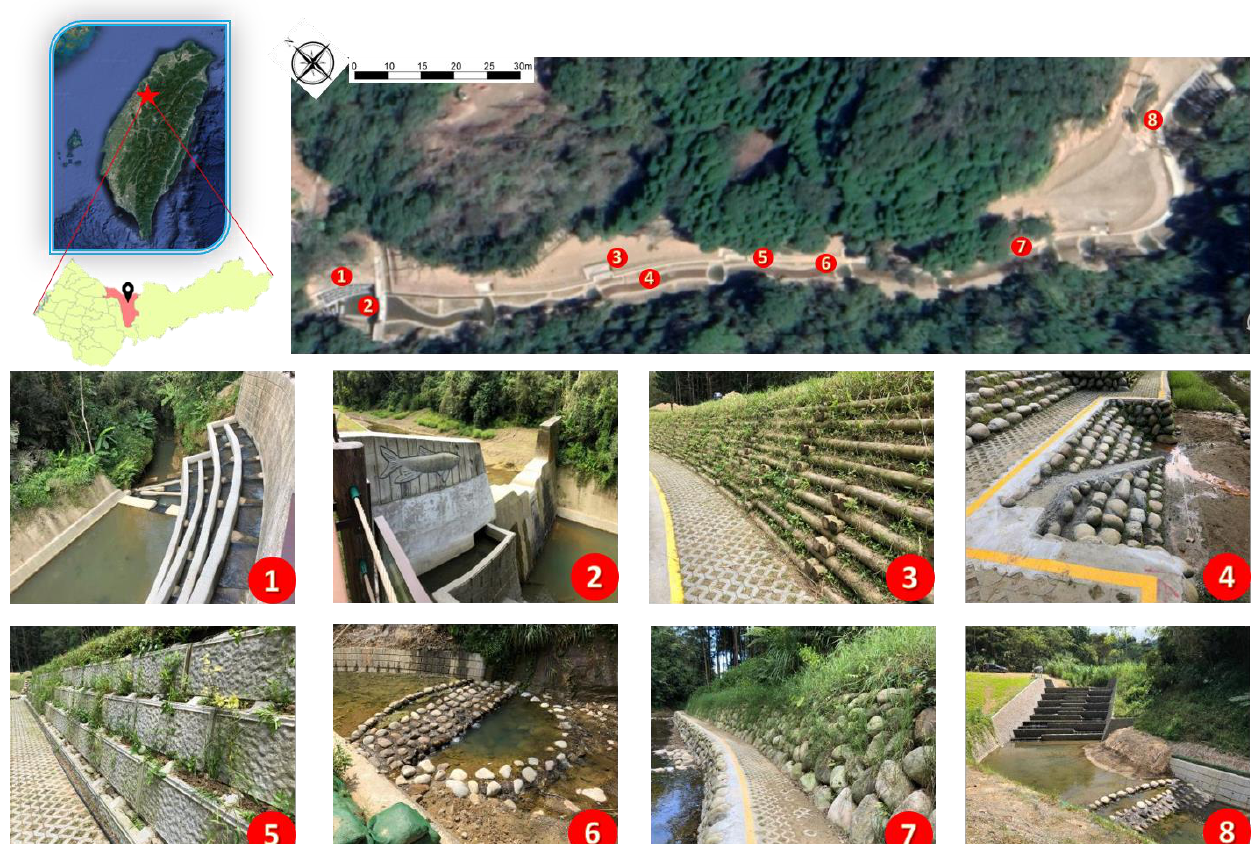
Figure 3. An on-site survey picture of the “Renovation Project of Sijiaolin Stream” for the 19th Excellent Award of the Public Construction Golden Quality Award for water conservancy (20 Septem- ber 2019).